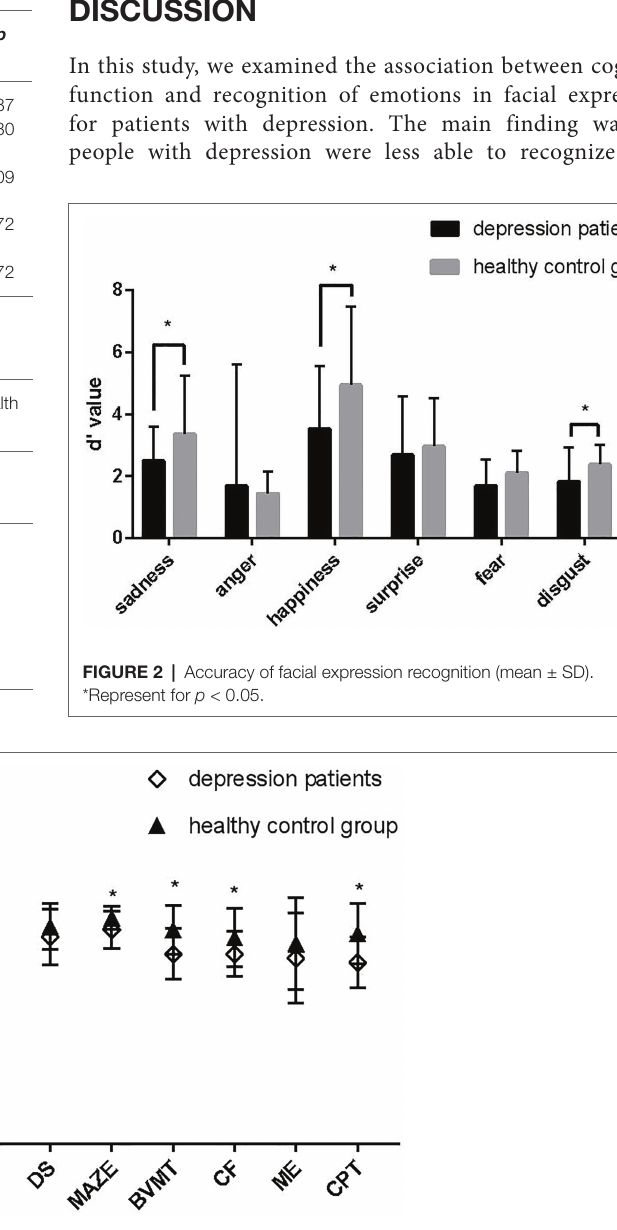
TABLE 1 | Descriptive information.